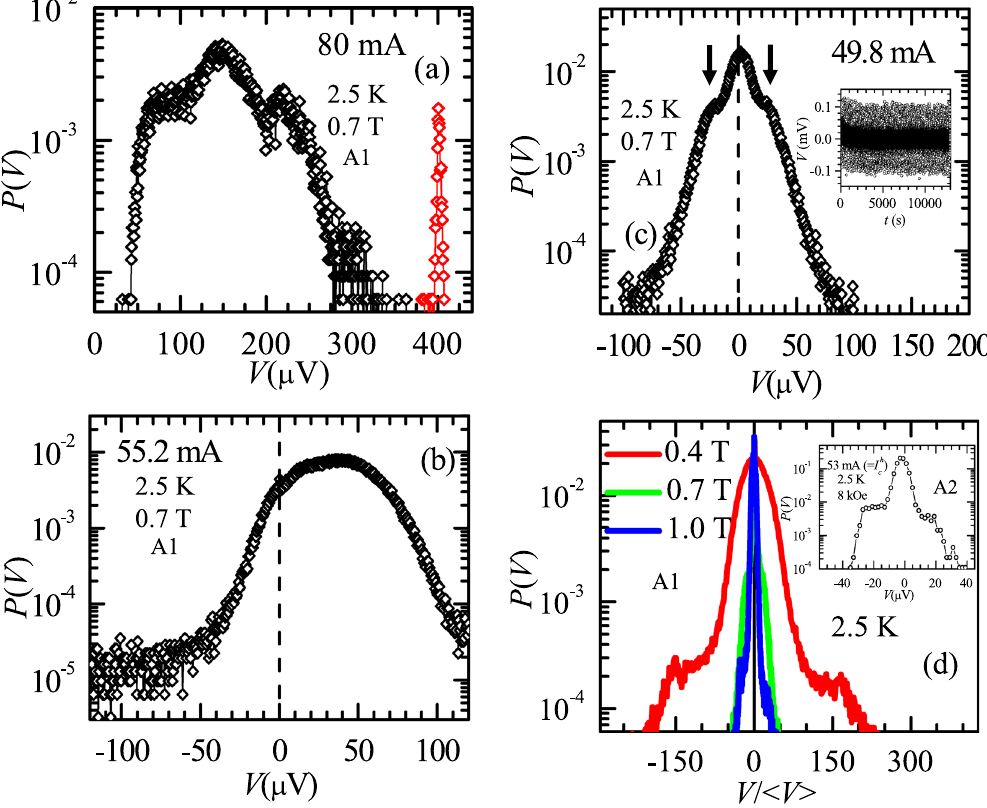
Figure 2. The probability distribution of output voltage. The probability distribution P ( V ) estimated from V ( t ) measured for sample A1 at 2.5 K and 0.7 T with I = ( a ) 80 mA, ( b ) 55.2 mA and ( c ) 49.8 mA. The inset of ( c ) presents the V ( t ) series measured at 2.5 K, 0.7 T with I = 49.8 mA. The vertical dashed straight lines in ( b , c ) identify V = 0 μ V line. ( d ) P ( V ) vs V / 〈 V 〉 for sample A1 at 2.5 K and I = 49.8 mA for different B : 0.4, 0.7